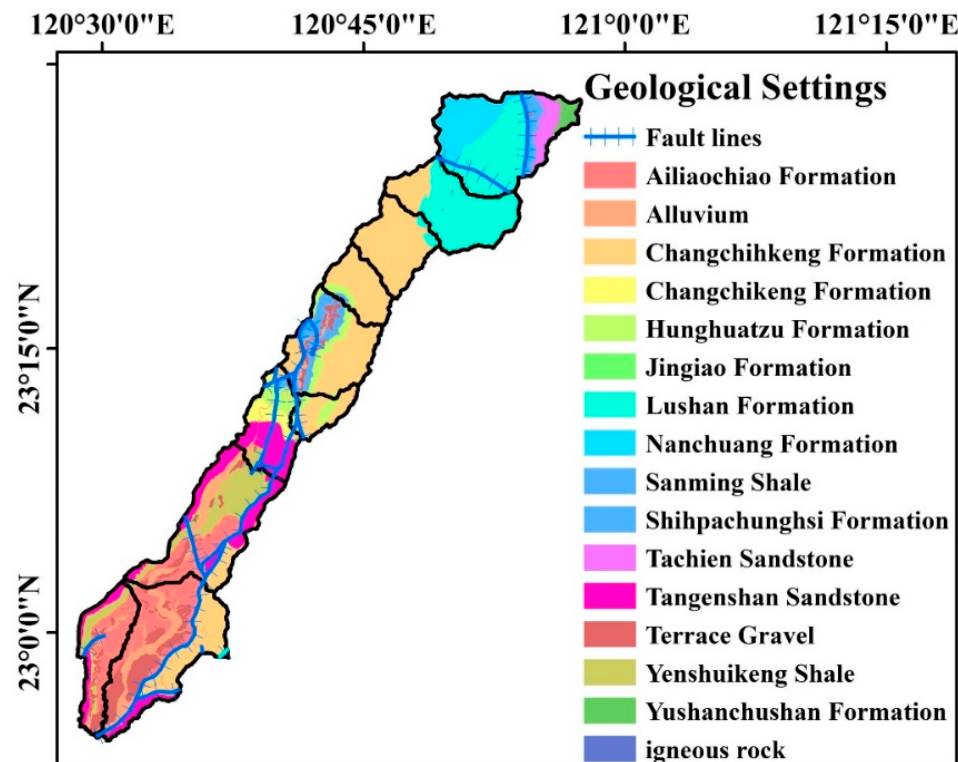
Figure 2. The geological settings in the Chishan river watershed.